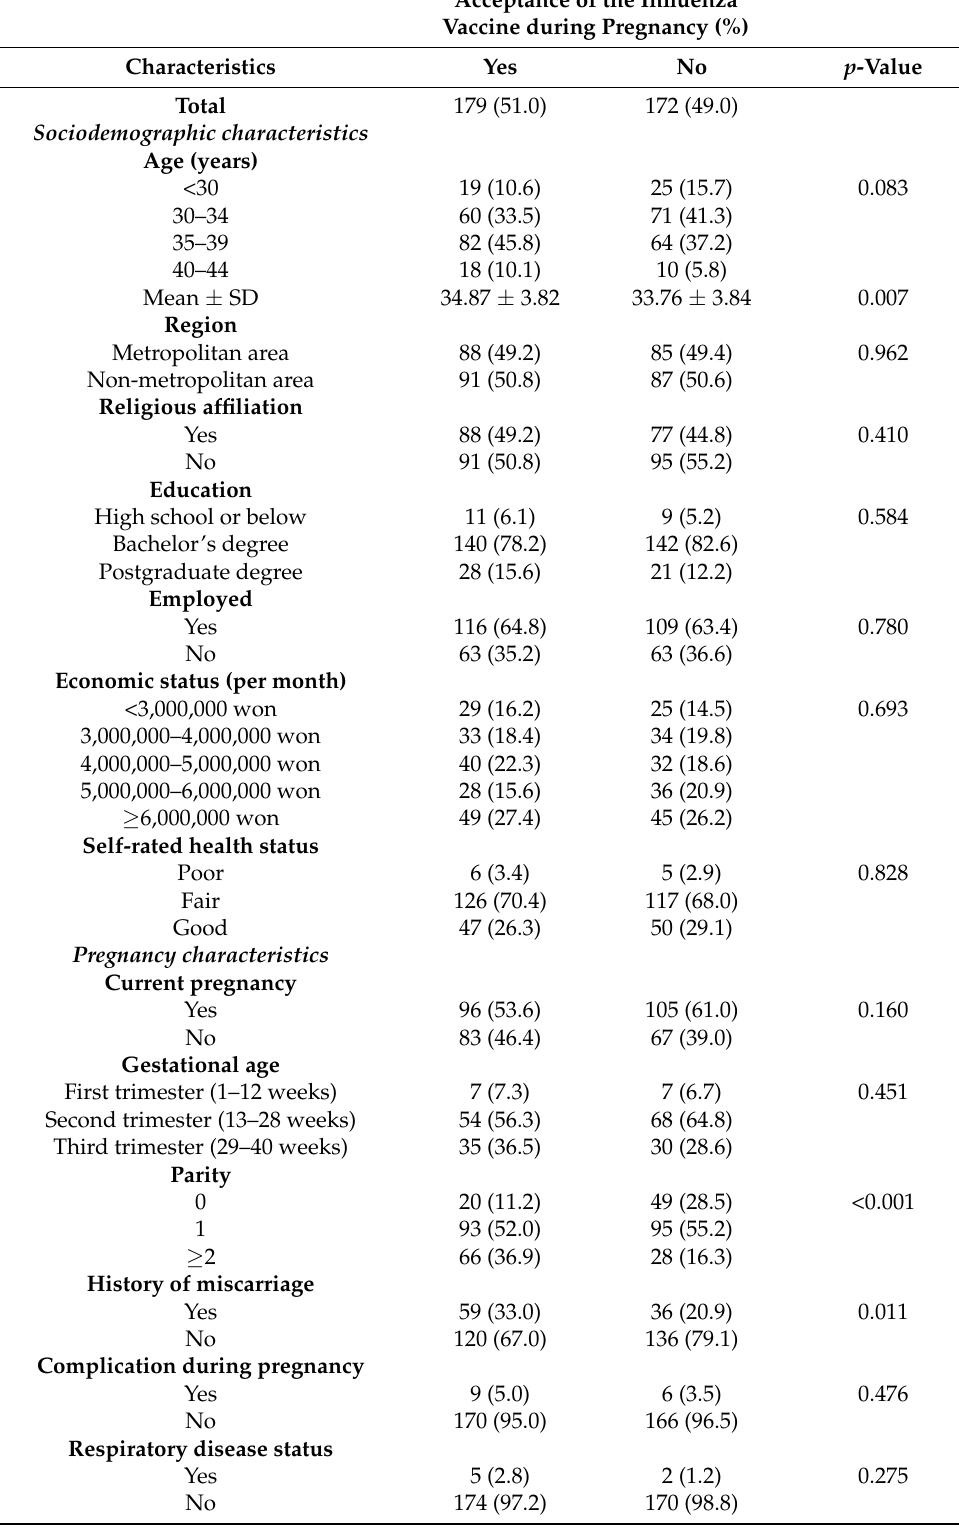
Table 2. Acceptance of the influenza vaccine among pregnant women by sociodemographic and pregnancy